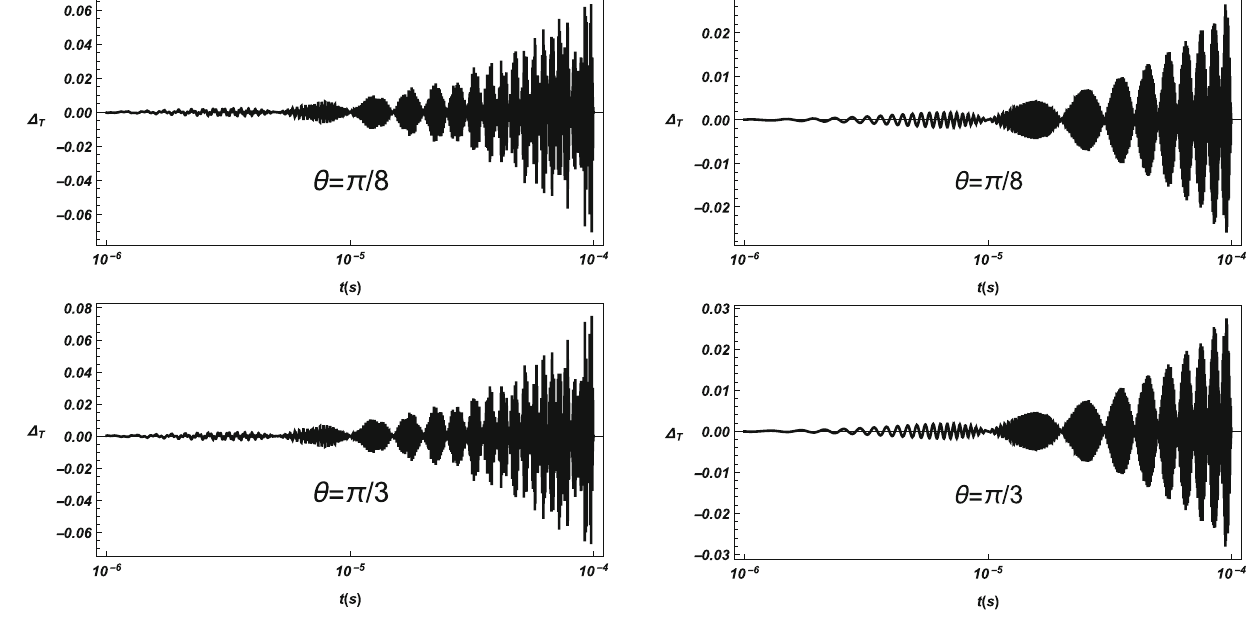
Fig. 2 Plots of (cid:14) T ( t ) for different choices of θ for a set-up with n = 4 trapped ions, and the same parameters as Fig. 1. Here we use a different time scale in order to better highlight the T -Violation